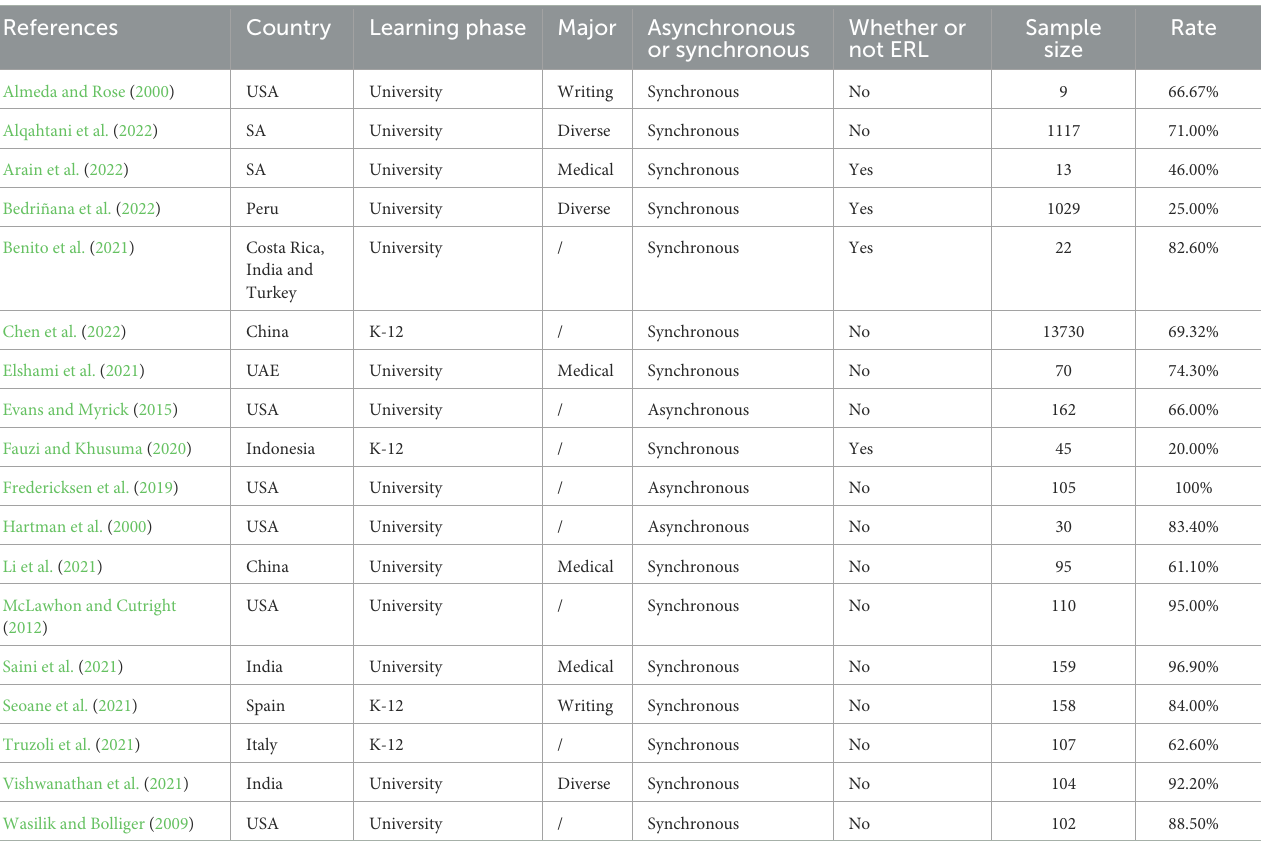
TABLE 2 Summary coding of included faculty satisfaction studies.